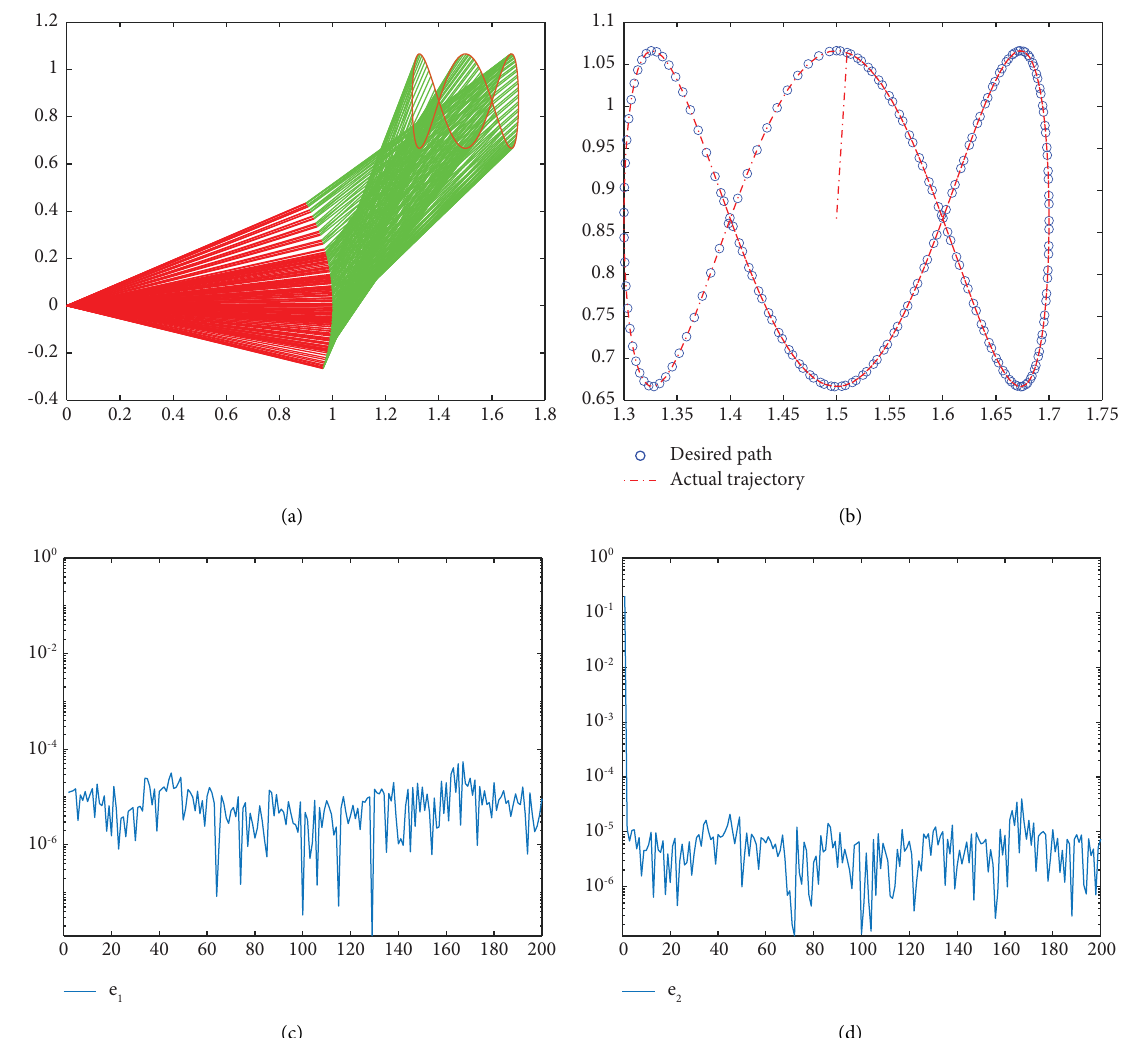
Figure 6: Numerical results generated by the MSMDL method for 􏽢 φ desired path, (c) tracking residual error on the x -axis, and (d) tracking residual error on the y -axis.